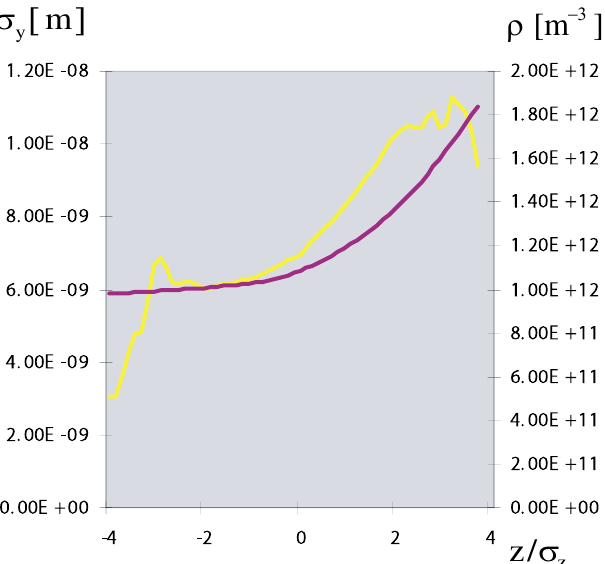
FIG. 55. (Color) Simulated vertical rms size of the positron beam in units of m (purple) and the electron density at the center of the beam 100 m upstream of the IP (yellow) as a function of along the bunch [55]; the bunch the longitudinal position z=(cid:16) z tail is on the